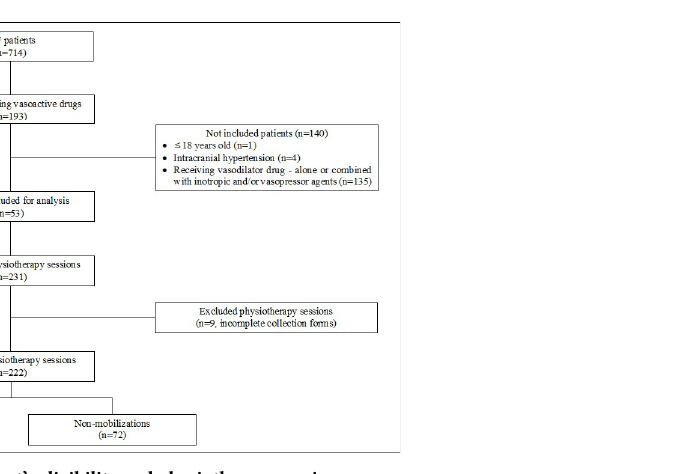
Fig 1. Flowchart of patient’s eligibility and physiotherapy sessions.